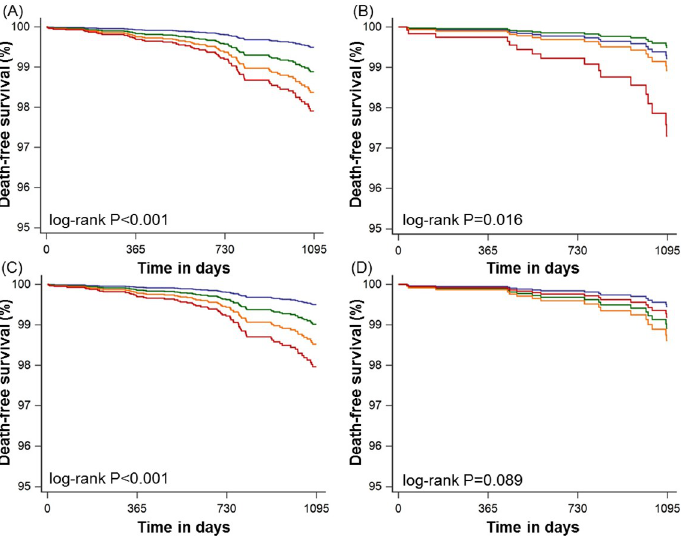
Fig 2. Kaplan-Meier survival curves for all-cause mortality-free survival. (A) coronary artery calcium score categories for patients without statin therapy, (B) coronary artery calcium score categories for patients with statin therapy, (C) segment involvement score categories for patients without statin therapy, and (D) segment involvement score categories for patients with statin therapy. Blue, green, orange, and red lines indicate 0, 1–99, 100–299, and � 300 coronary artery calcium score categories. Blue, green, orange, and red lines indicate 0, 1, 2–3, and � 4 segment involvement score categories.